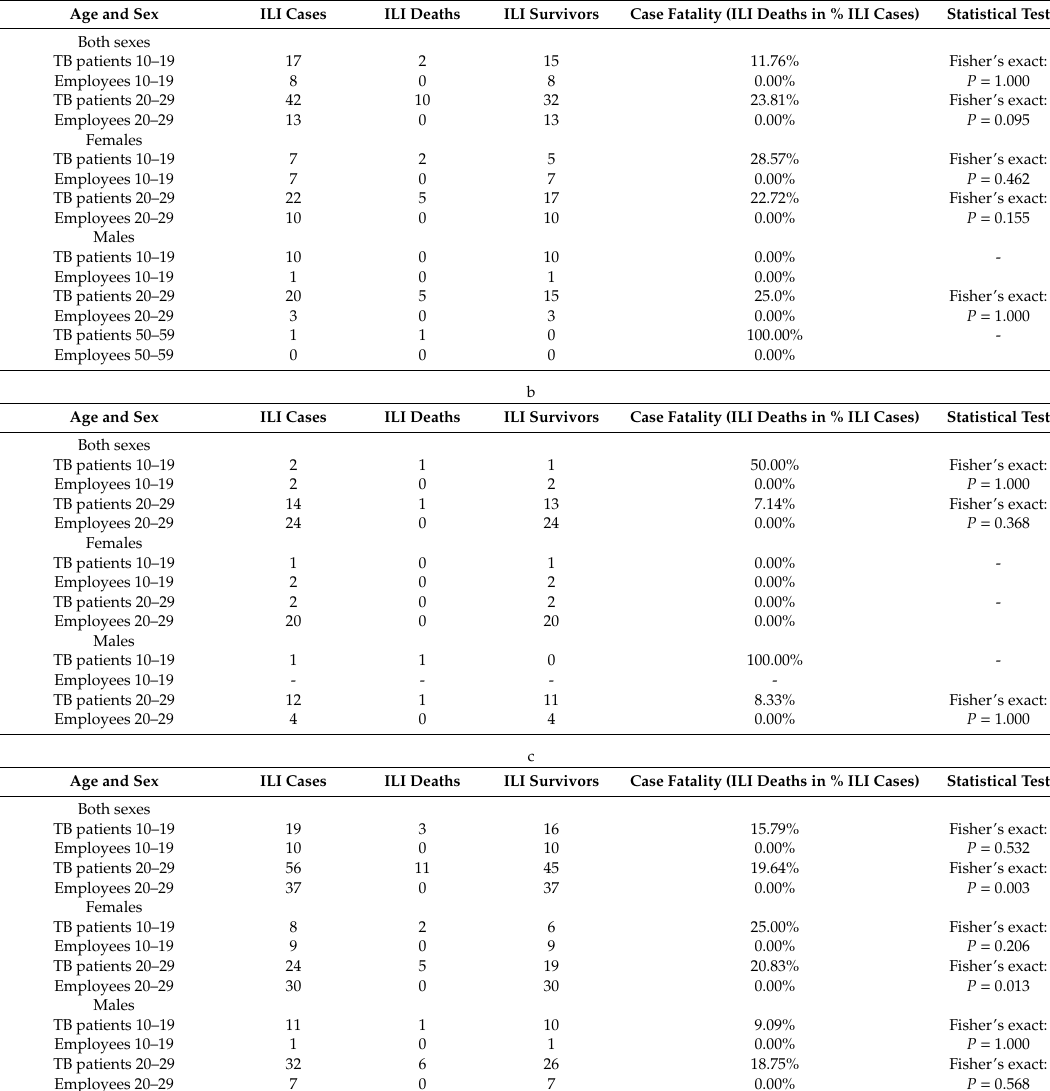
Table 5. (a) Cross tabulation of tuberculosis and conditional risk of ILI death among ILI cases by age, sex, and both sexes combined at Lyster sanatorium during the 1918 fall wave; (b) Cross tabulation of tuberculosis and conditional risk of ILI death among ILI cases by age, sex, and both sexes combined at Landeskogen sanatorium during the 1918 fall wave; (c) Cross tabulation of tuberculosis and conditional risk of ILI death among ILI cases by age, sex, and both sexes combined during the 1918 fall wave. Both